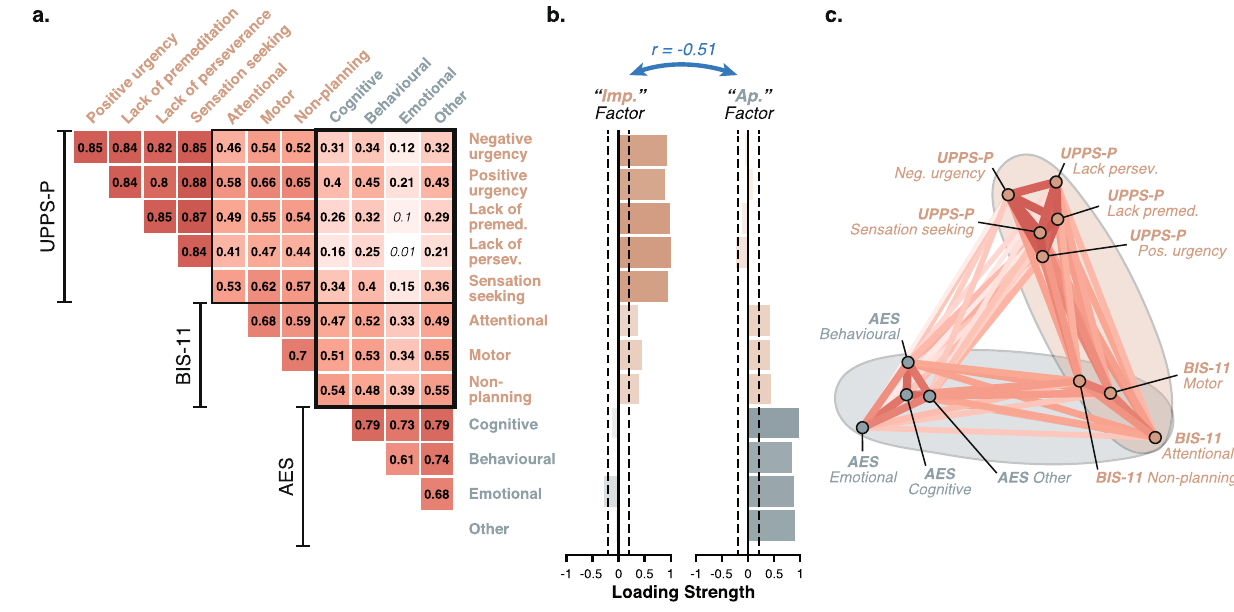
Figure 3. BIS-11 sub-scales contribute equally to apathy and impulsivity. ( a ) The correlation matrix of the sub-scale scores of the UPPS-P, BIS-11 and AES questionnaires showed positive correlations only (Dataset 3, n = 809 complete observations). Significant pairwise correlations are shown in bold (Bonferroni-corrected). The black square highlights cross-questionnaire associations. ( b ) Factor decomposition (EFA) of this matrix uncovered dissociable, anti-correlated ( r = − 0.51 ), “Apathy” and “Impulsivity” factors. BIS-11 sub-scales contributed equally to both factors. ( c ) The network plot showed a characteristic isosceles clustering. More highly correlated (positively or negatively) appear closer together and are joined by stronger paths (non- significant paths removed). Paths are also coloured by their sign (red for positive and blue negative). Ellipses are drawn around the sub-scores included in a